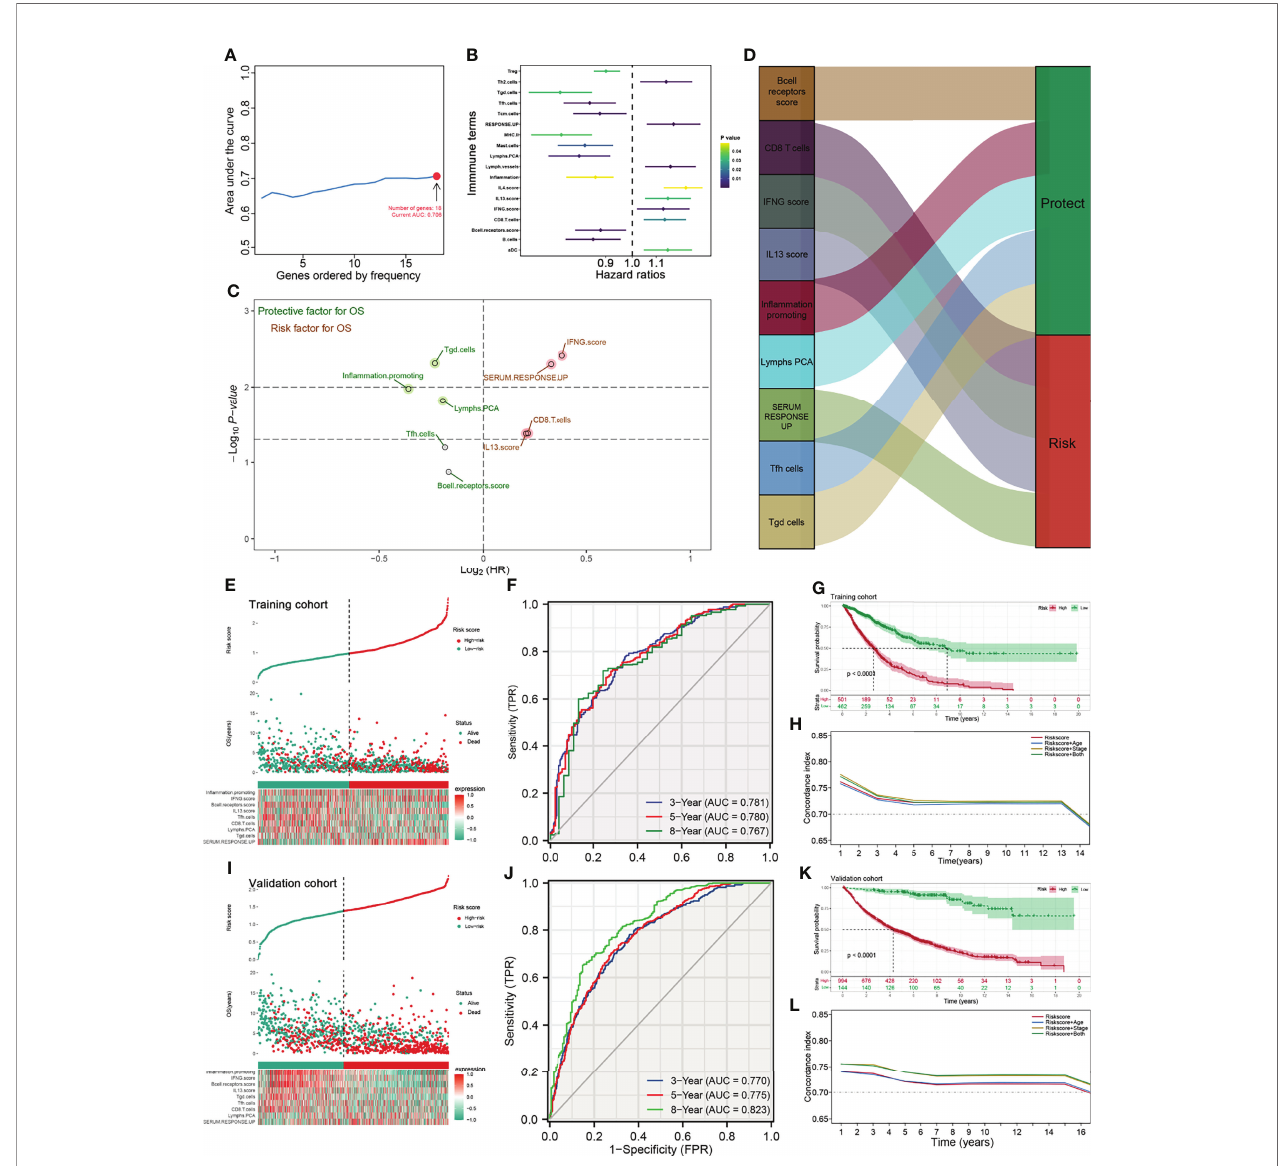
FIGURE 3 | Identi fi cation the immune terms signi fi cantly associated with patients prognosis. (A) Iterative LASSO regression was used for high-frequency features selection and 18 prognosis-related terms were retained; (B) Univariate Cox analysis was performed to identi fi ed prognosis-related immune terms with the threshold of P < 0.05; (C, D) Multivariate Cox analysis was performed to identify immune terms for prognosis-model construction; (E) Risk plot showed a higher percentage of dead cases in the high IRS group (training cohort); (F) ROC curve showed a satisfactory prediction ef fi ciency of prognosis model; (G) Kaplan-Meier survival curve showed that high IRS patients might have a worse OS; (H) Time-dependent ROC curve showed that IRS signature has stable predictive ability of OS in a different time (training cohort); (I – L) The risk plot, ROC curve, Kaplan-Meier survival curve and Time-dependent ROC curve in validation